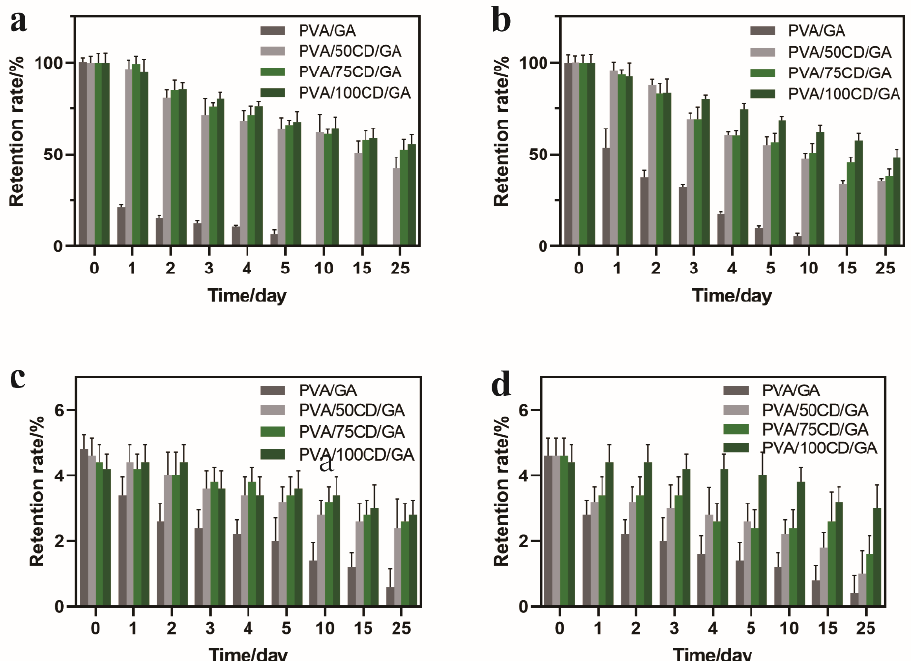
Figure 5. Fragrance retention HPLC results of cis -jasmone ( a ) and citronella ( b ) for PVA/GA, PVA/50CD/GA, PVA/75CD/GA and PVA/100CD/GA fibers; single-blind result of cis -jasmone ( c ) and citronella ( d ) for PVA/GA, PVA/50CD/GA, PVA/75CD/GA and PVA/100CD/GA fibers.